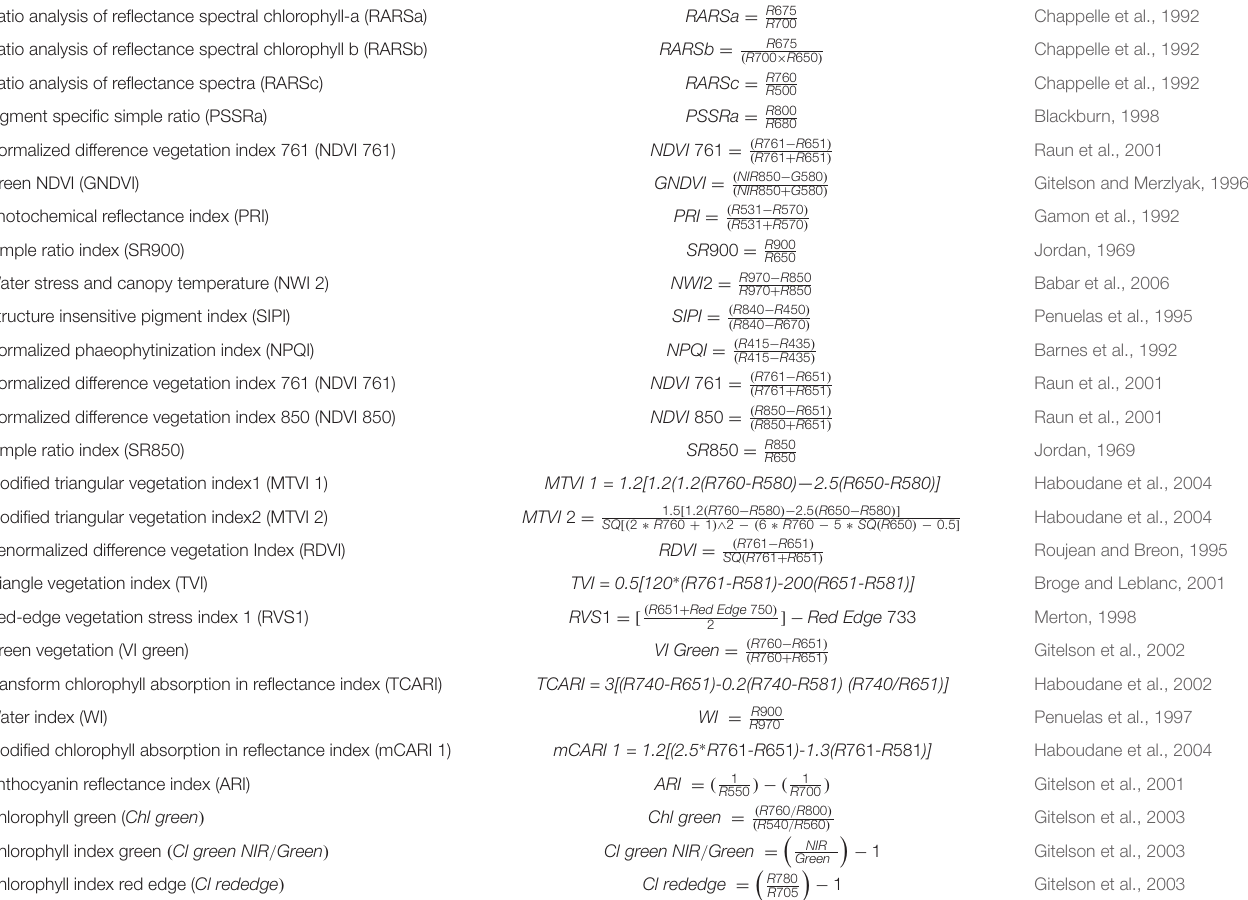
TABLE 1 | Spectral vegetation indices evaluated for downy mildew disease